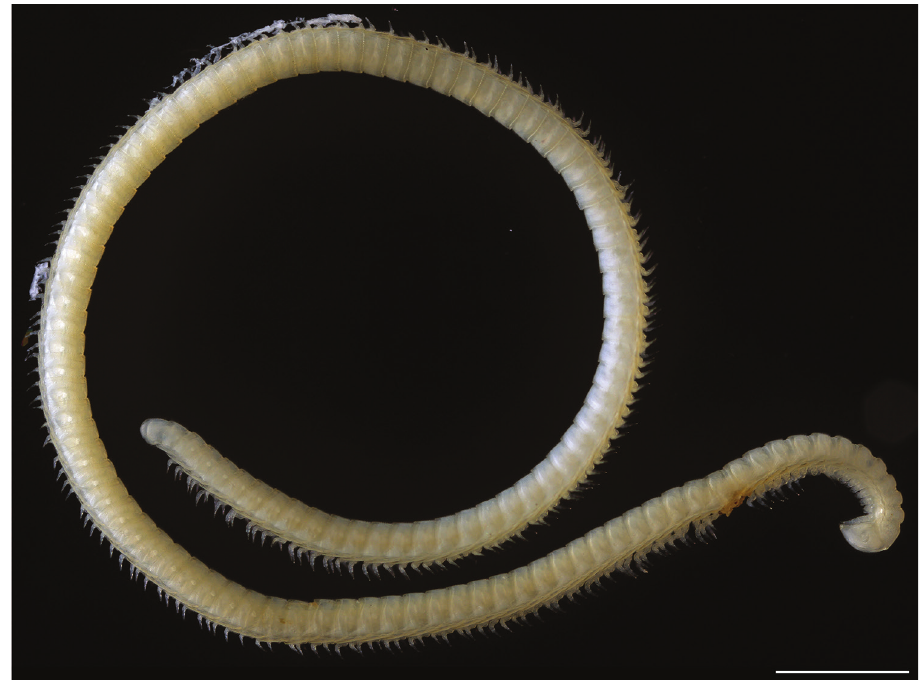
Figure 13. Illacme tobini sp. n.: ♂ holotype. Scale bar 1 mm. (Catalog #: